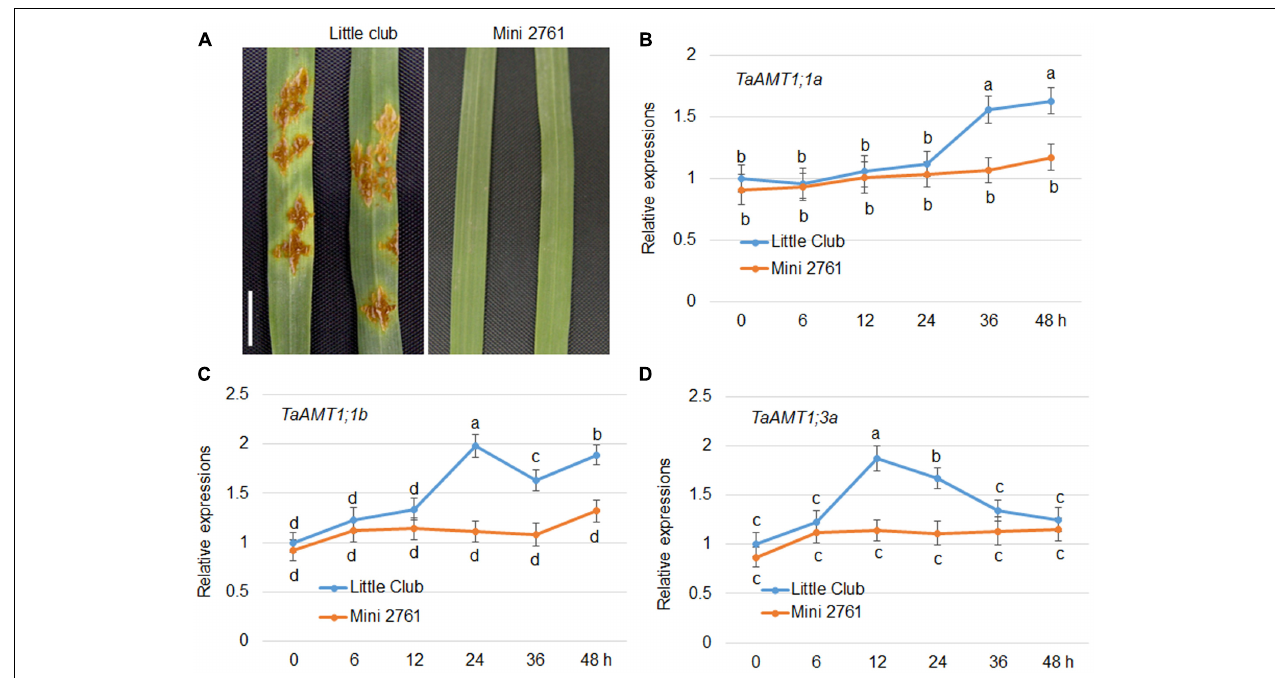
FIGURE 7 | Urediniospore infection-mediated expression patterns of TaAMT1;1 genes. Phenotype of uredinia growth in two different wheat varieties. Leaves of 4-week-old LC and Mini 2761, a stem rust susceptible and immune line, respectively, were inoculated with urediniospores. After 7 days of infection, the uredinia on the surface of the leaves were photographed. Bar = 1 cm. Leaves of 4-week-old LC and Mini 2761 were inoculated with urediniospores, and the leaves were collected for RNA extraction 0, 6, 12, 24, 36, and 48 h after inoculation. TaAMT1;1 gene expressions were monitored by qRT-PCR (A) . The levels of TaAMT1;1a (B) , TaAMT1;1b (C) , and TaAMT1;3a (D) , before inoculation (0 h) was defined as 1. The relative ratio shown is the ratio against 1. The experiments were repeated three times and significant differences at P < 0.05 level are indicated by different letters.